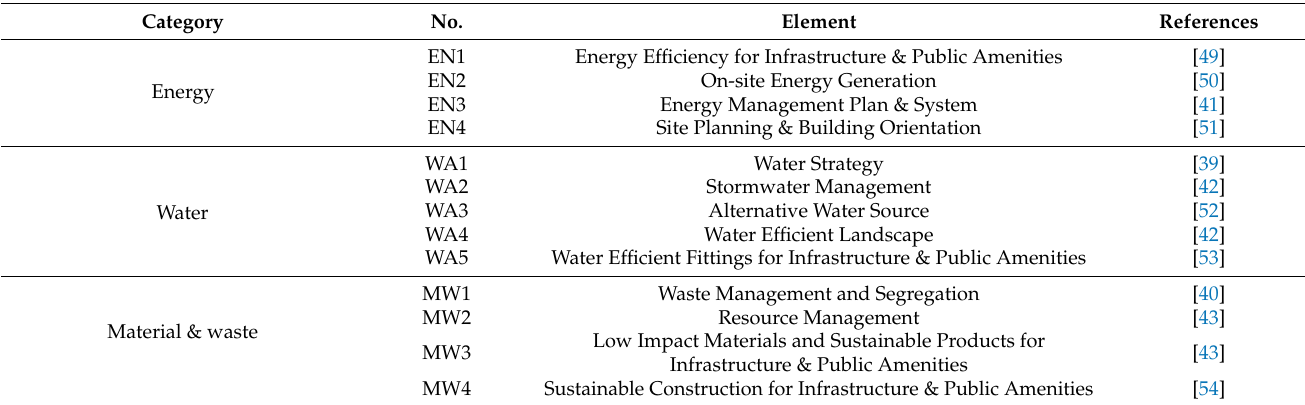
Table 3. The preliminary elements of attentions for enhancing urban